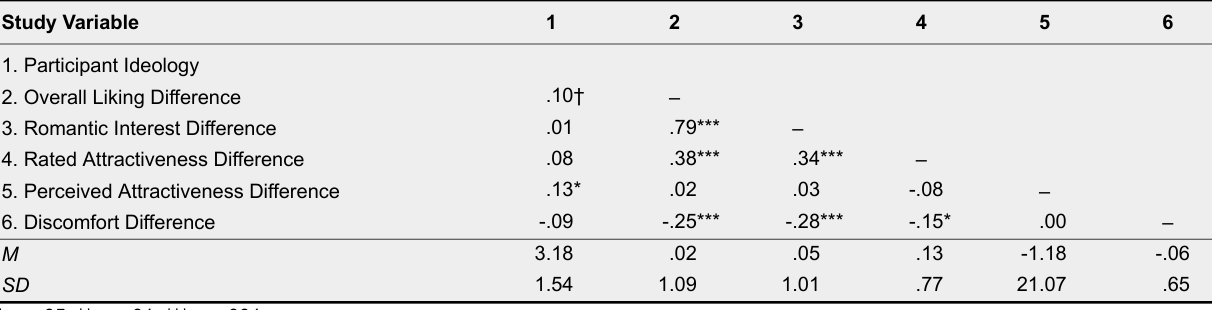
Study 2: Correlations and Descriptive